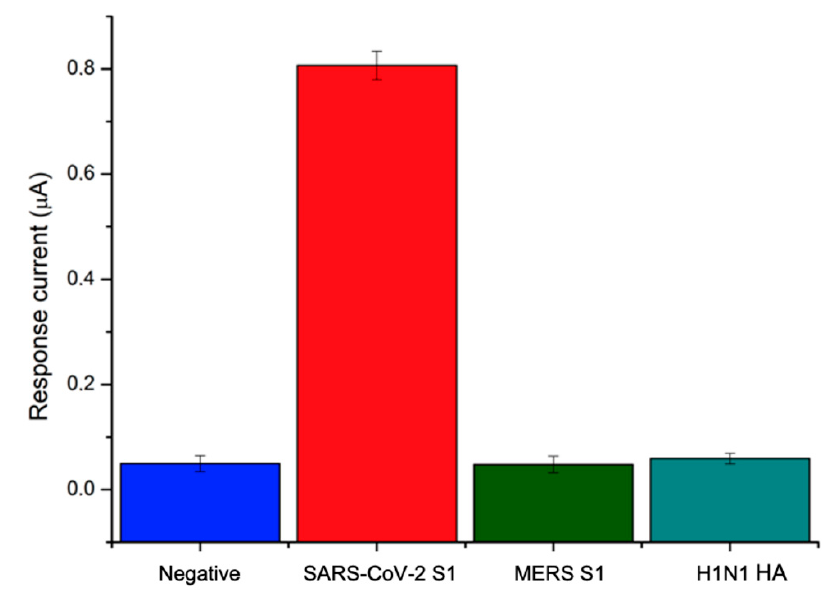
Figure 6. Specificity of the immunosensor’s response to MERS S1 and H1N1 HA